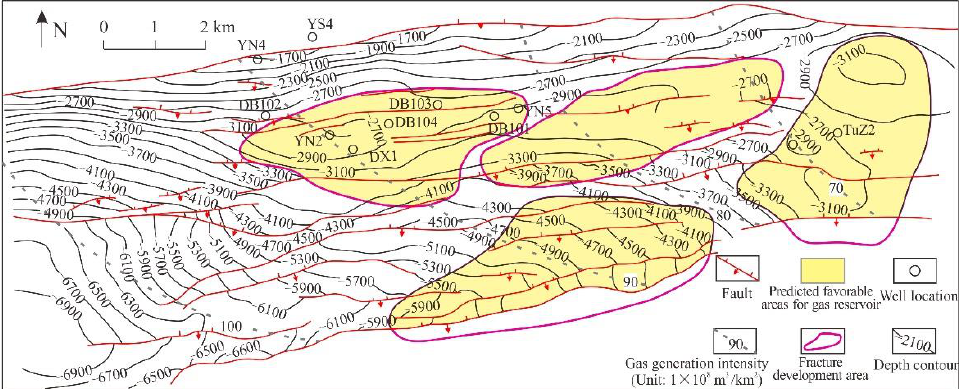
Figure 15. Sweet spots area for J 1 a tight sandstone in the Dibei reservoir (the source rock data are from Caineng Zou, 2011 [37]; fracture data are modified from Hailiang Kang, 2016 [24]).